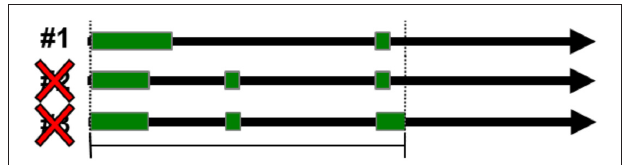
FIGURE 3 | Positional redundancy elimination. Redundant loci were identified by overlapping genomic spans and were eliminated so that only one locus could occupy the same genomic